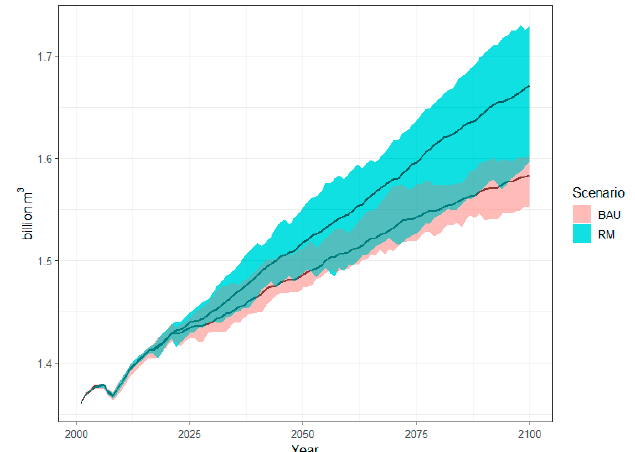
Figure 5. Projected land-use related water demand in billions of cubic meters (Bm 3 ) from 2001–2100 in California’s Central Coast under a business-as-usual (BAU; red) and recent modern (RM; blue) scenarios. Darker center lines represent the mean and shaded area represents the maximum and minimum values across 10 Monte Carlo simulations.